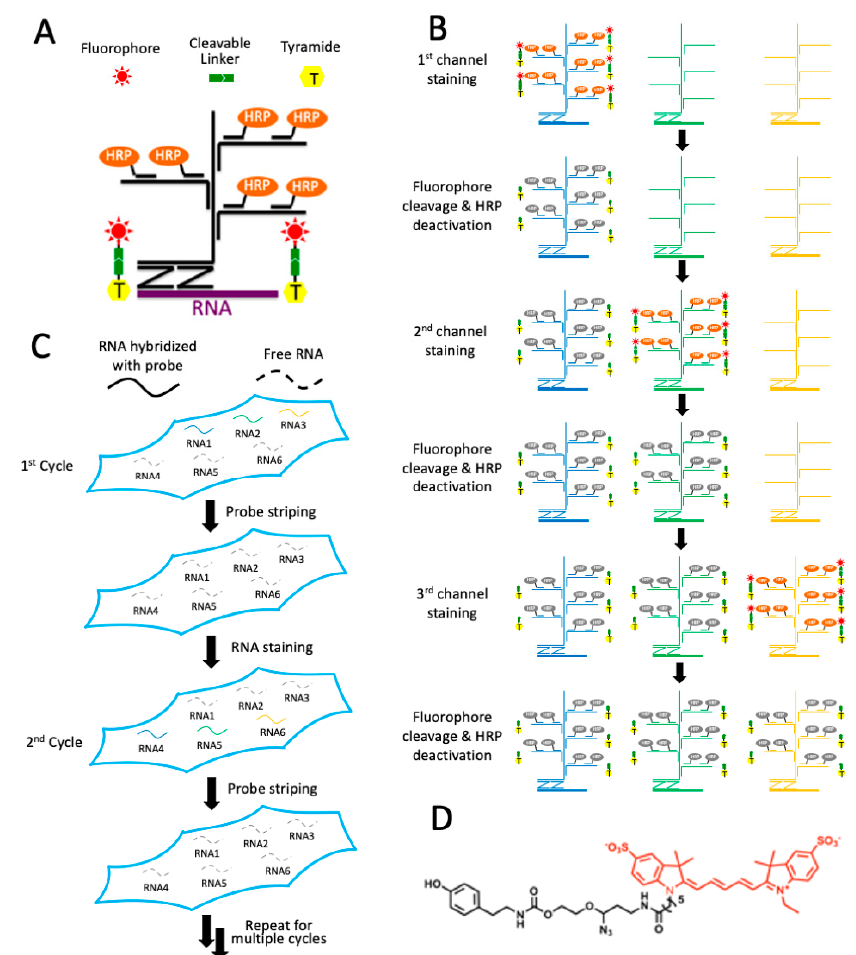
Figure 1. Highly sensitive and multiplexed in situ RNA profiling with cleavable fluorescent tyramide (CFT). ( A ) In each cycle, multiple transcripts of interest are hybridized by oligonucleotide probes in pairs, which recruit oligonucleotide amplification probes. With further signal amplification by horseradish peroxidase (HRP), the target RNA is stained with CFT. ( B ) After imaging, the fluorophores are chemically cleaved and HRP is deactivated, allowing other RNA targets to be stained in the same cycle. ( C ) After all the RNA targets are stained in a cycle, all the hybridized probes are stripped. Through reiterative cycles of RNA staining and probe stripping, a large number of transcripts can be profiled in single cells in situ. ( D ) Structure of CFT, tyramide-N 3 -Cy5.